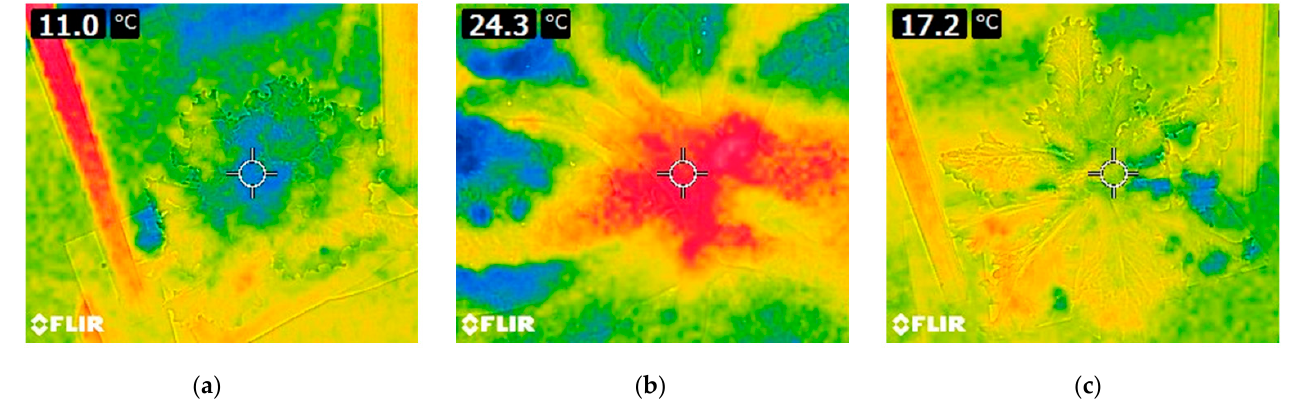
Figure 11. Average leaf area for three crops.